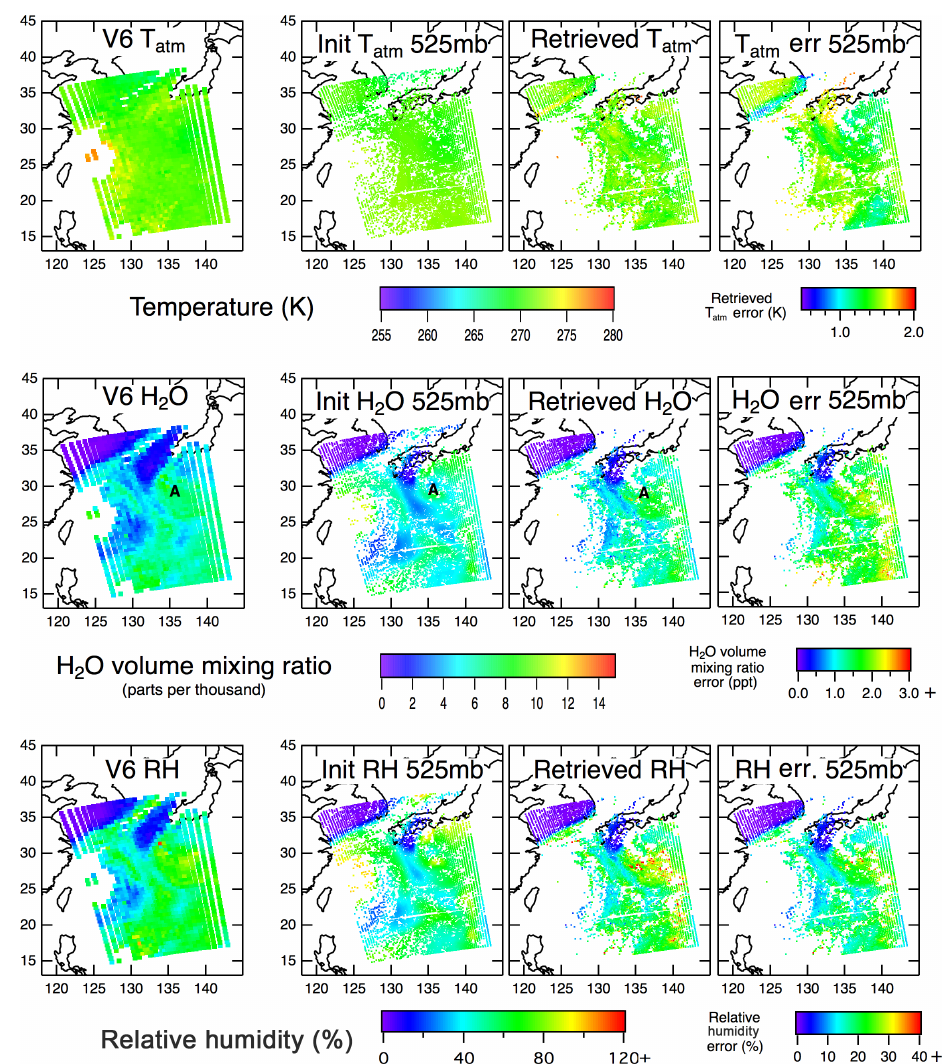
Figure 9. AIRS V6 retrieval and AIRS-OE a priori data, retrievals and estimated errors for temperature, water vapor and relative humidity (RH) at 525mb for (daytime) Granule 44, 6 September